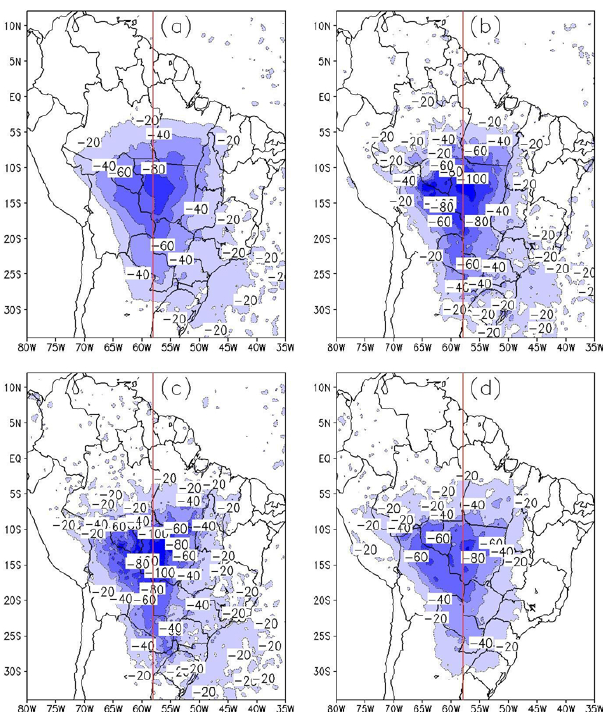
Fig. 11. Biomass burning season mean surface radiative flux pertur- bation at specific times calculated by averaging differences between the downward surface solar irradiance including and excluding the aerosol direct radiative effect. (a) 12:00UTC, (b) 15:00UTC, (c) 18:00UTC and (d)